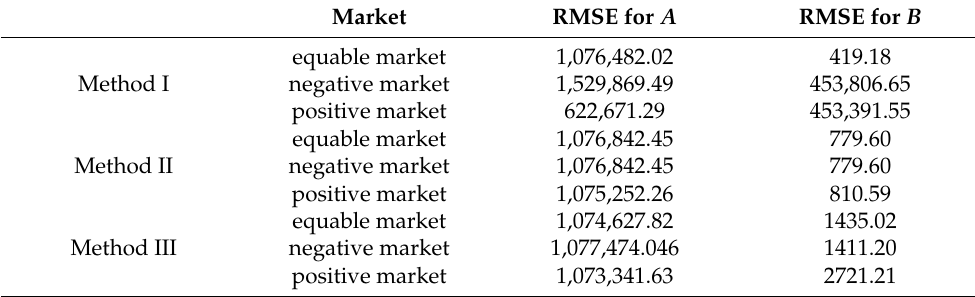
Table 4. RMSE of the three